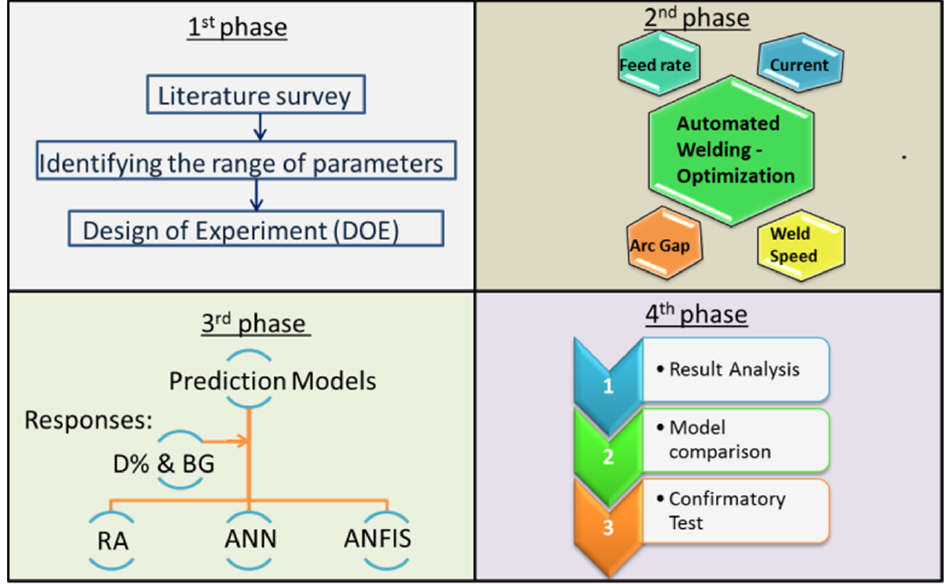
Figure 1. Architecture of the current investigation.